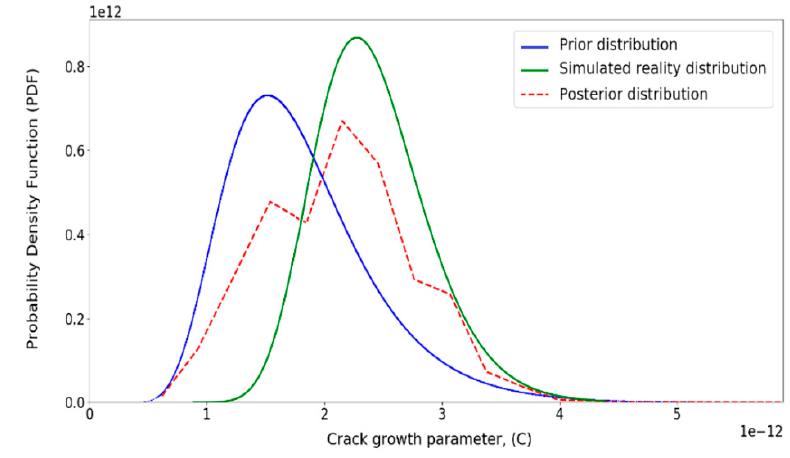
Figure 16. Updated distribution for initial crack size (a 0 )